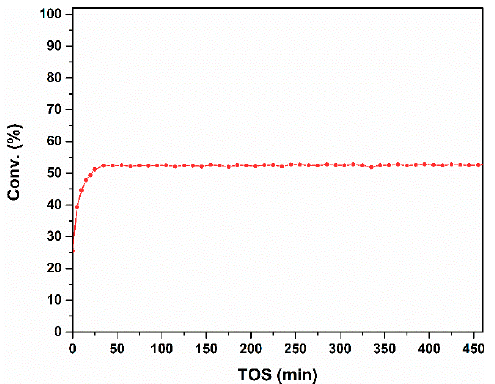
Figure 4. Stability test of the CO oxidation over the FeCu/Al 2 O 3 catalyst. Reaction conditions: W cat = 0.3 g, F tot = 150 mL/min, P CO = 0.02 bar, O 2 /CO = 10/1, T = 250 °C, P tot = 1 bar.